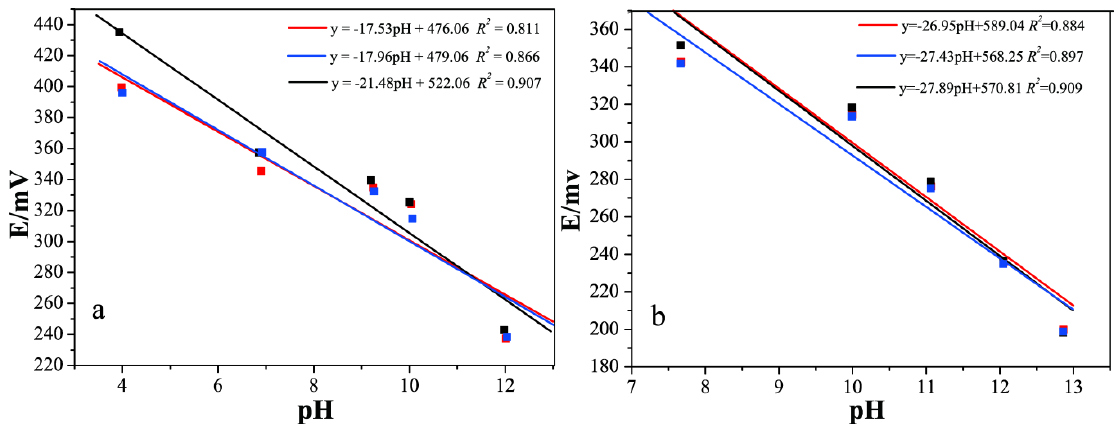
Figure 3. The correlation of the prepared electrode ( a ) the response potential and the pH values of standard pH buffers, and ( b ) the response potential and the pH values of the Na 2 SiO 3 solutions with concentrations of 10 − 1 – 10 − 5 M.